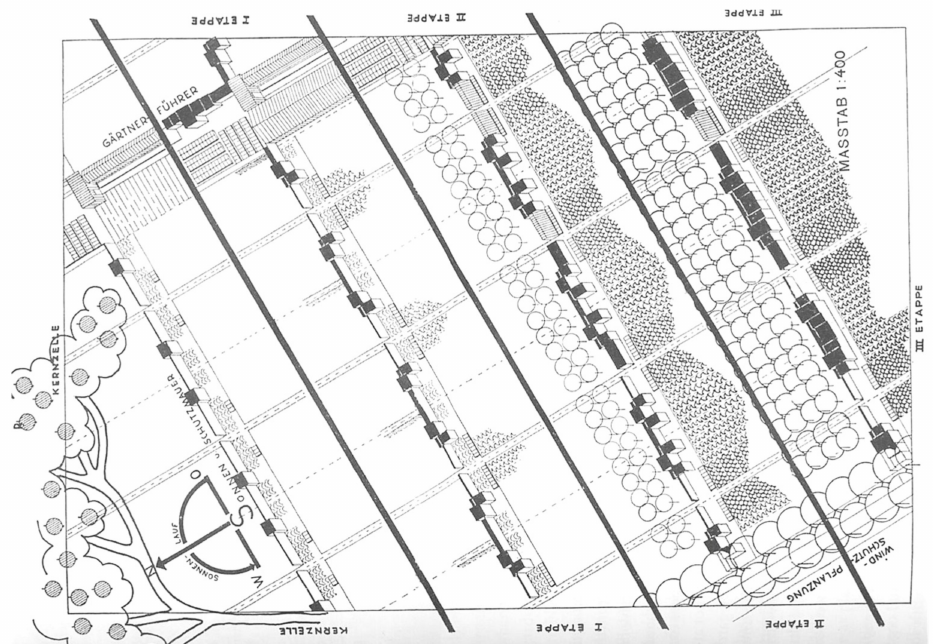
Figure 3. Diagram showing the stages of development of the self-sufficient residential area (Germ. Siedlung , by Migge L.), (Leberecht Migge, 1932, p.